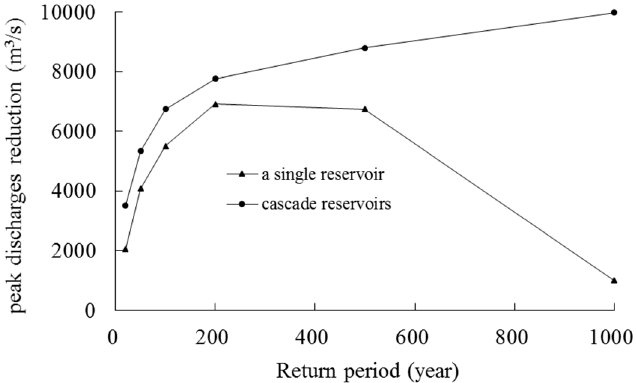
Figure 8. Design peak discharges reduction at the Gaobazhou reservoir site under the influence of upstream reservoirs operation.